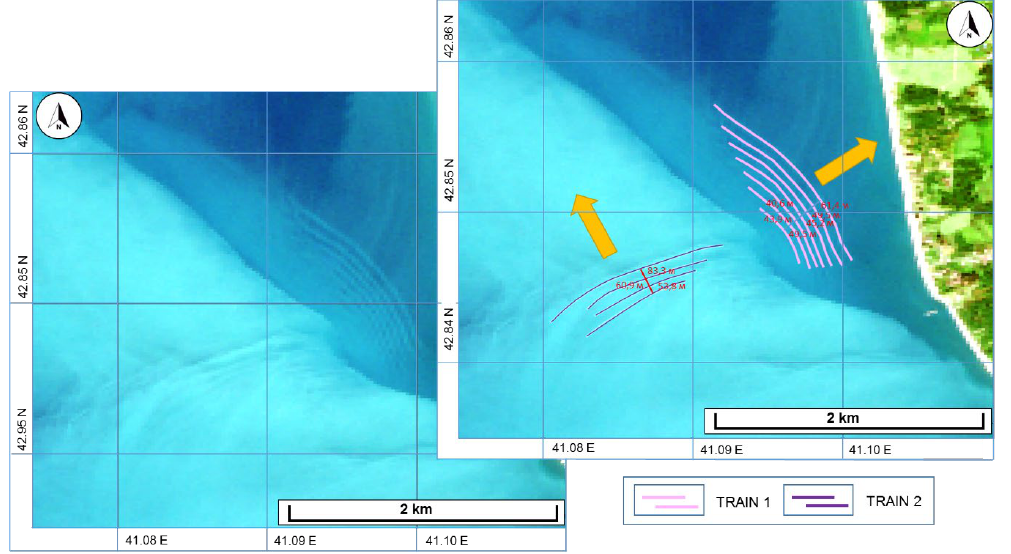
Figure 6. Fragment II of the satellite image (Sentinel-2, 10 September 2017) shows the trains of internal waves generated by the plume of the Kodor River (arrows show the direction of movement of the trains).